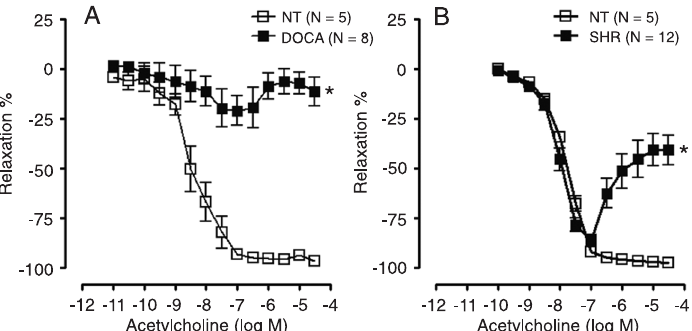
Figure 1. Endothelium-dependent relaxation induced by acetylcholine in mes- enteric resistance arteries from adult (3 months old) DOCA-salt hypertensive rats (DOCA) ( A ), spontaneously hypertensive rats (SHR) ( B ) and normotensive male Wistar rats (NT) ( A , B ). Note that the response elicited by acetylcholine in arteries from the DOCA and SHR groups is biphasic and induces contraction at high concentrations. DOCA-salt hypertension was induced in male